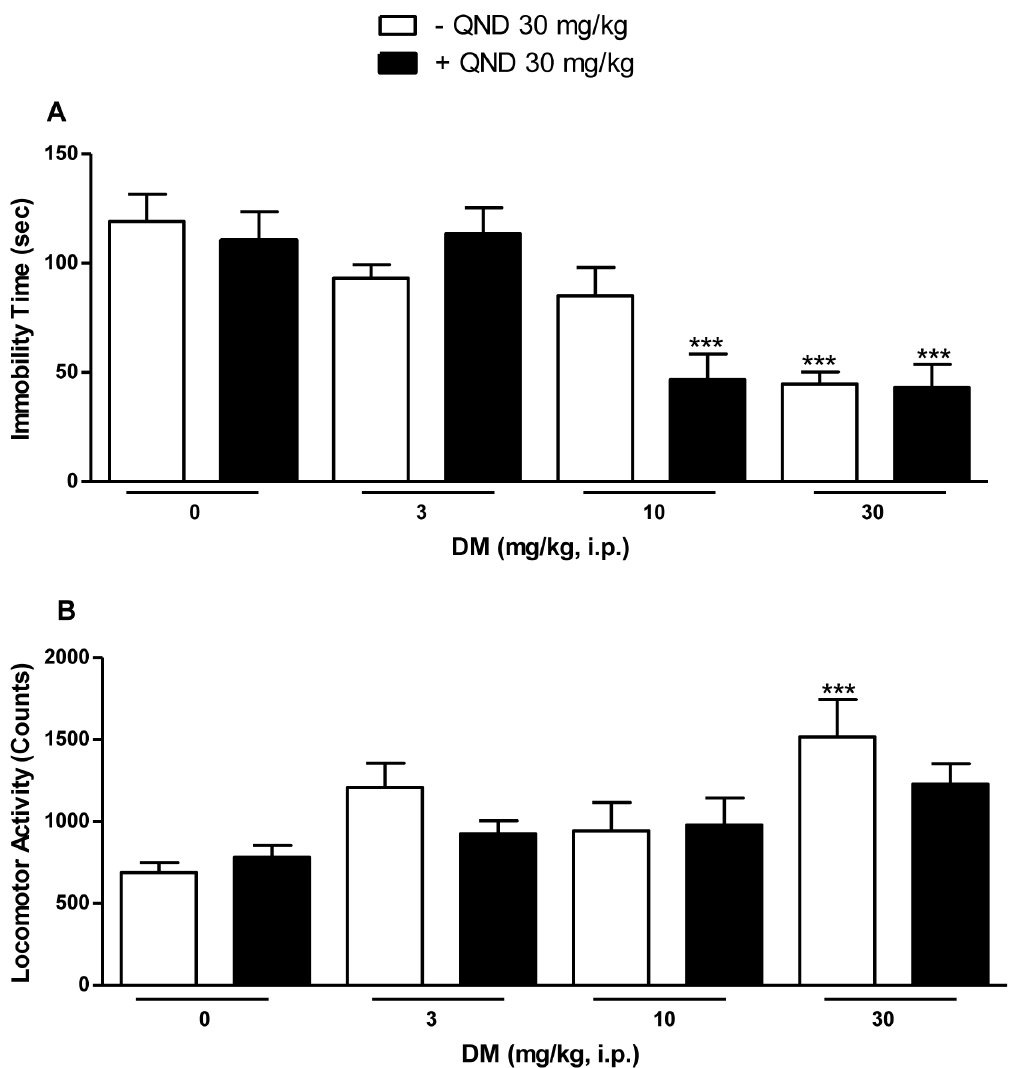
Figure 4. Potentiation of the antidepressant-like effects of dextromethorphan by quinidine. A single dose of the CYP2D6 inhibitor quinidine (30 mg/kg, i.p.) administered concomitantly with dextromethorphan (0–30 mg/kg, i.p.) significantly potentiated the decrease in immobility time for dextromethorphan at 10 mg/kg (A). In contrast, in the locomotor study, dextromethorphan in combination with quinidine had no stimulatory effects (B). Data shown are expressed as mean 6 S.E.M. *** P , 0.001, compared with the saline-treated group; one-way ANOVA followed by post-hoc Tukey’s tests. QND, quinidine. DM, dextromethorphan.